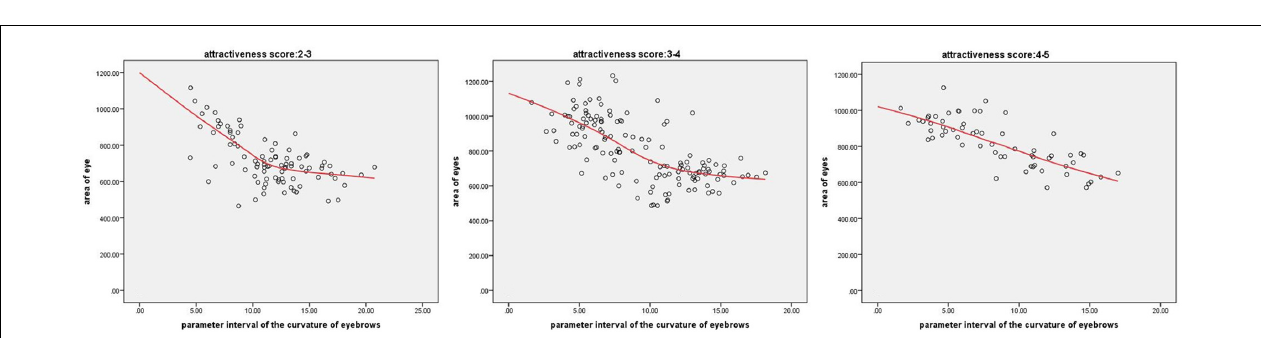
FIGURE 11 | The three figures are distributions of area of iris, proportion of iris to whole eye, area of eye, respectively. The horizontal axis is the interval of the described parameter. The vertical axis is the number of images in the parameter interval.